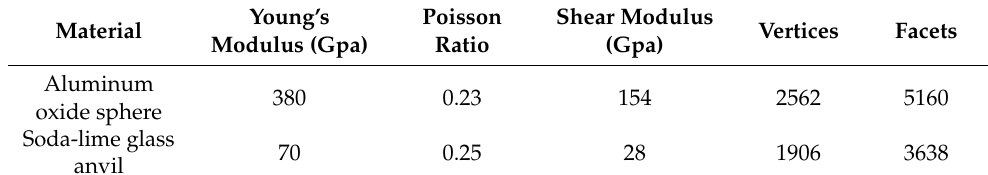
Table 1. Characteristics of the material.